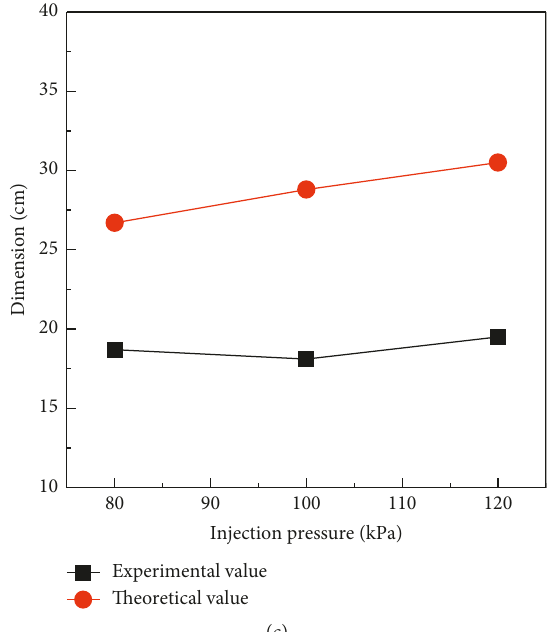
Figure 9: The transverse dimension of grout concretion under different ( w / c ) ratios. ( w / c ) ratios of (a) 1.0, (b) 1.5, and (c)